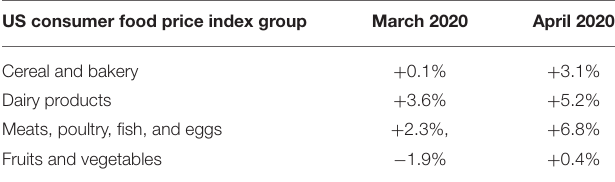
TABLE 2 | US consumer Food Price Index changes (index based on US$) in March and April 2020 as compared to the respective previous month (US Bureau of Labor Statistics,